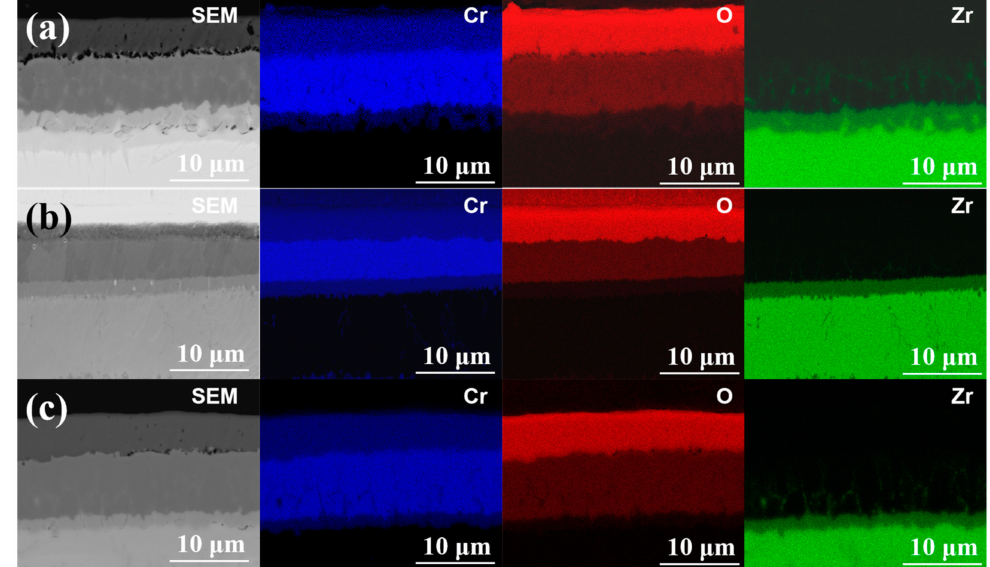
Figure 9. EDS mapping of the longitudinal section of the coatings after oxidized at 1200 ◦ C. ( a ) 1#, ( b ) 2# and ( c )